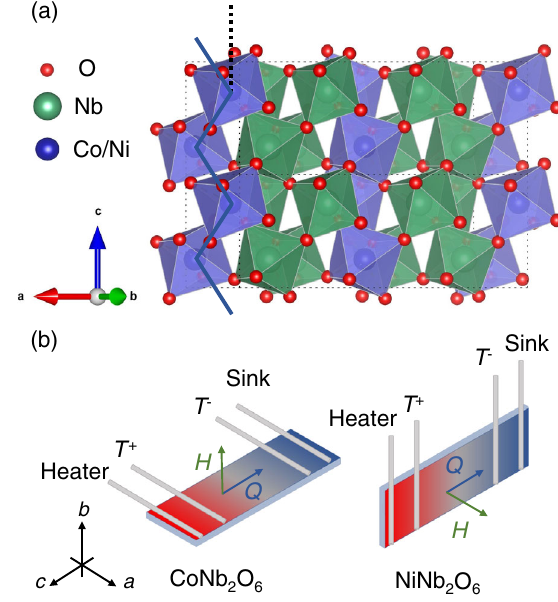
FIG. 1. (a) The crystal structure of CoNb 2 O 6 and NiNb 2 O 6 . The blue solid line highlights the zigzag chain formed by Co or Ni spins. Note that there is a finite canting angle between the local easy axis (not shown) and the c axis (thick dotted line), and the direction of the former not to be confused with the zigzag chain (thick solid line). (b) The experimental setup for thermal conductivity measurements for CoNb 2 O 6 and NiNb 2 O 6 . The magnetic field was applied along b for CoNb 2 O 6 and along a for NiNb 2 O 6